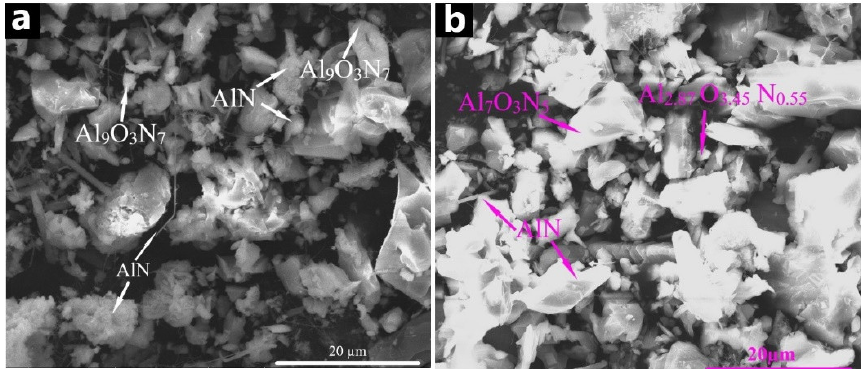
Figure 11. The structure of the combustion products obtained from the (70% AlN + 30% Al) samples with the parameters: q = 3 cm 3 /(s∙cm 2 ), ( a ) nitrogen flow, ( b ) nitrogen–argon flow.